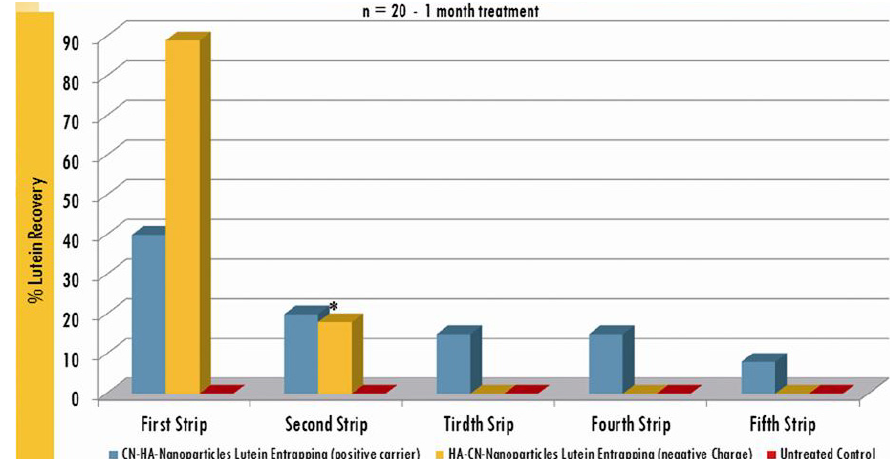
Figure 6. Lutein recovery of different stripped skin layers after one month of treatment by CN-nanoparticles applied on left or right forearm. All p values are significant ( p < 0.005) as control and as groups; * = not significant.